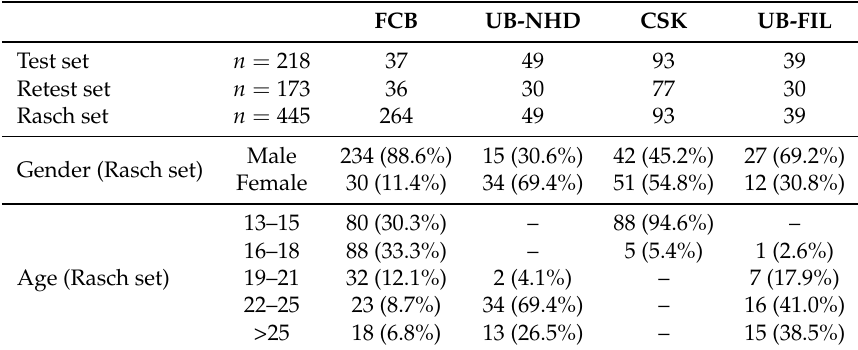
Table 1. Characteristics of the groups participating in the questionnaire validation study. Numbers for each group expresses frequencies and percentages.